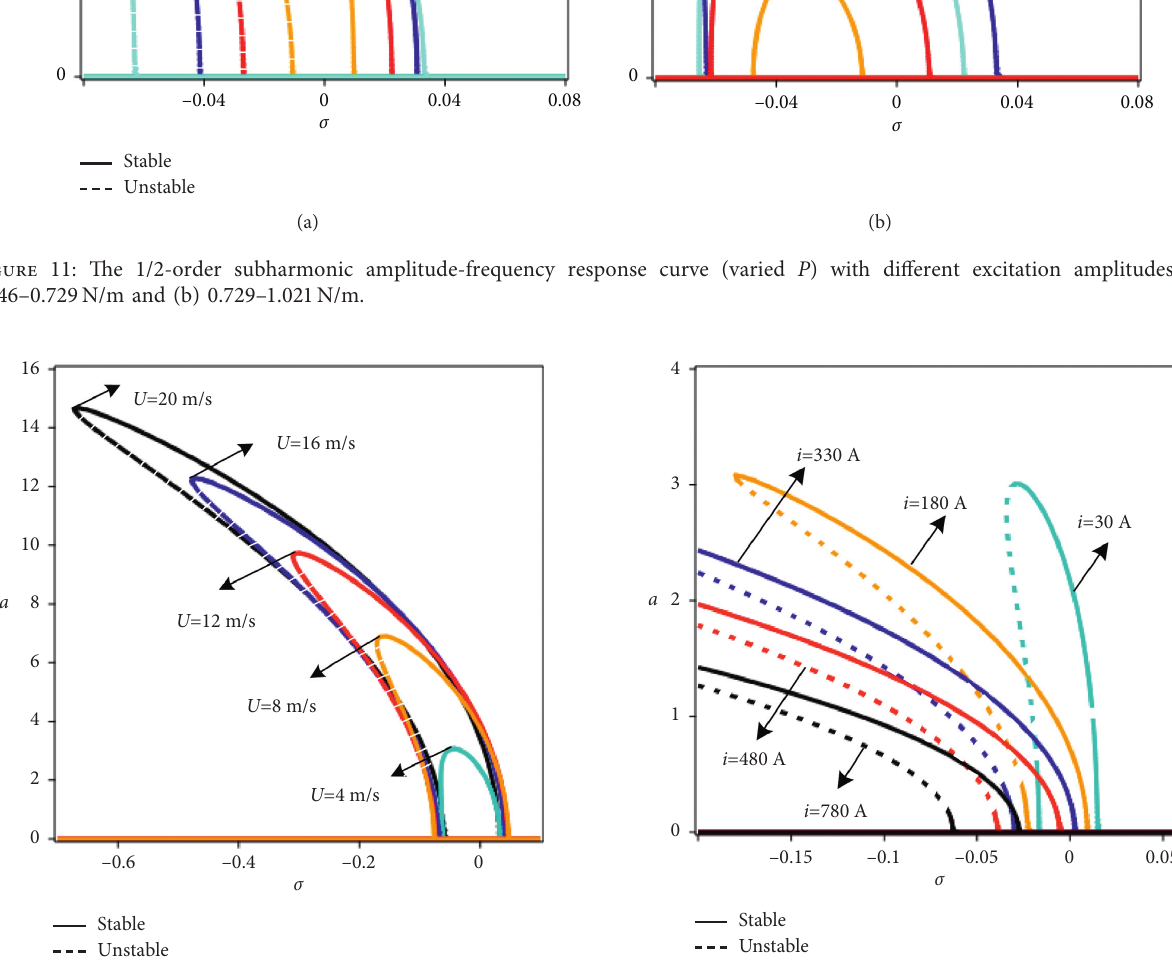
Figure 12: The 1/2-order subharmonic amplitude-frequency re- sponse curve (varied U ).